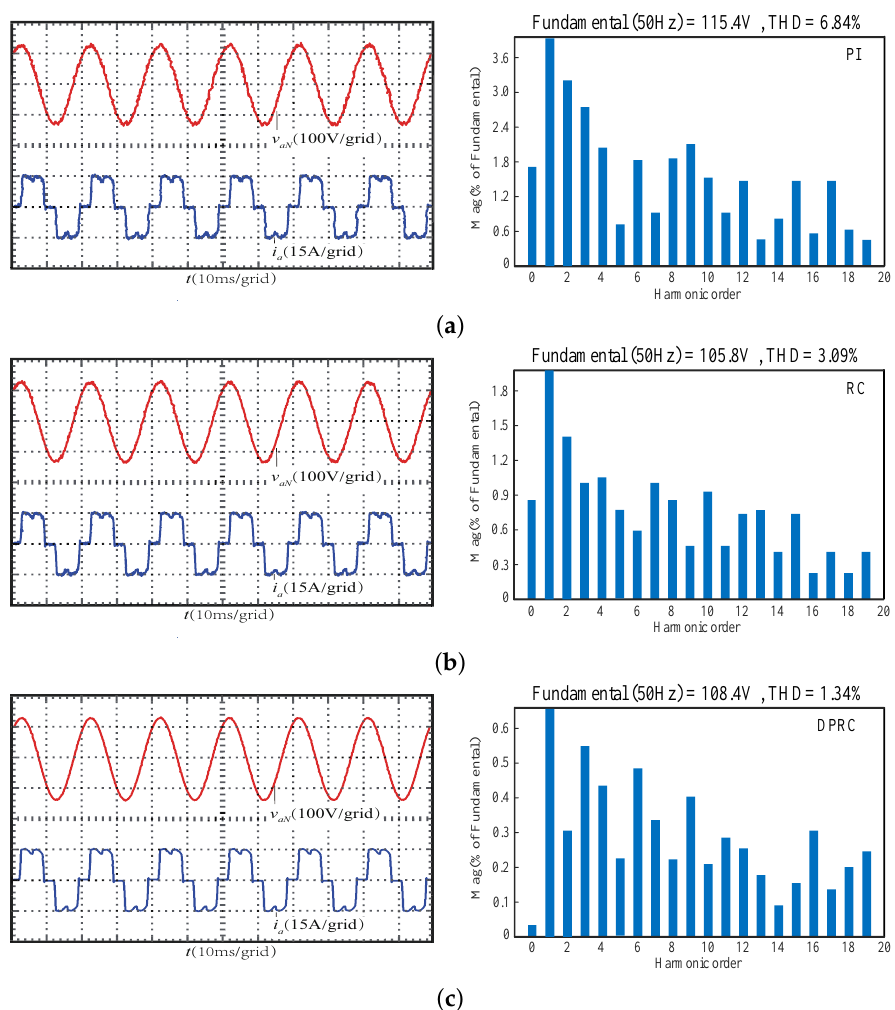
Figure 16. Voltage, current and voltage waveform distortion under nonlinear load. ( a ) PI controller ( b ) RC controller ( c ) DPRC